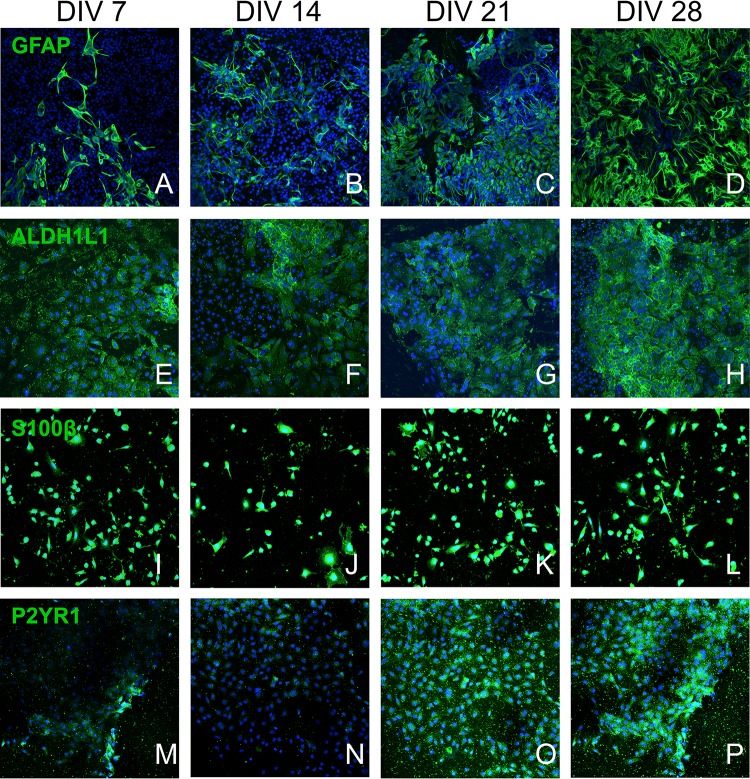
Confocal culture micrographs (7–28 DIV) of astrocytes inducted from mESC, immunofluorescently labeled for established astrocytic markers: (A–D) – GFAP, (E–H) – ALDH1L1, (I–L) – S100B, and (M–P) – P2Y1R. Cell nuclei marker H-33342 (blue stain). Scale bar 20 μm.